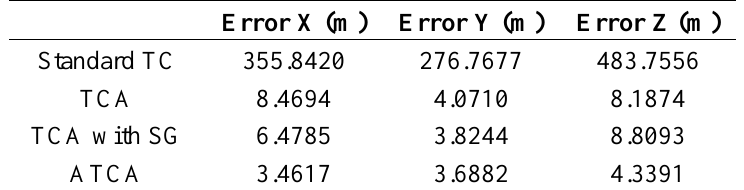
Figure 14. Position result of ATCA. Table 5. RMS of the position error in the ECEF frame of the whole